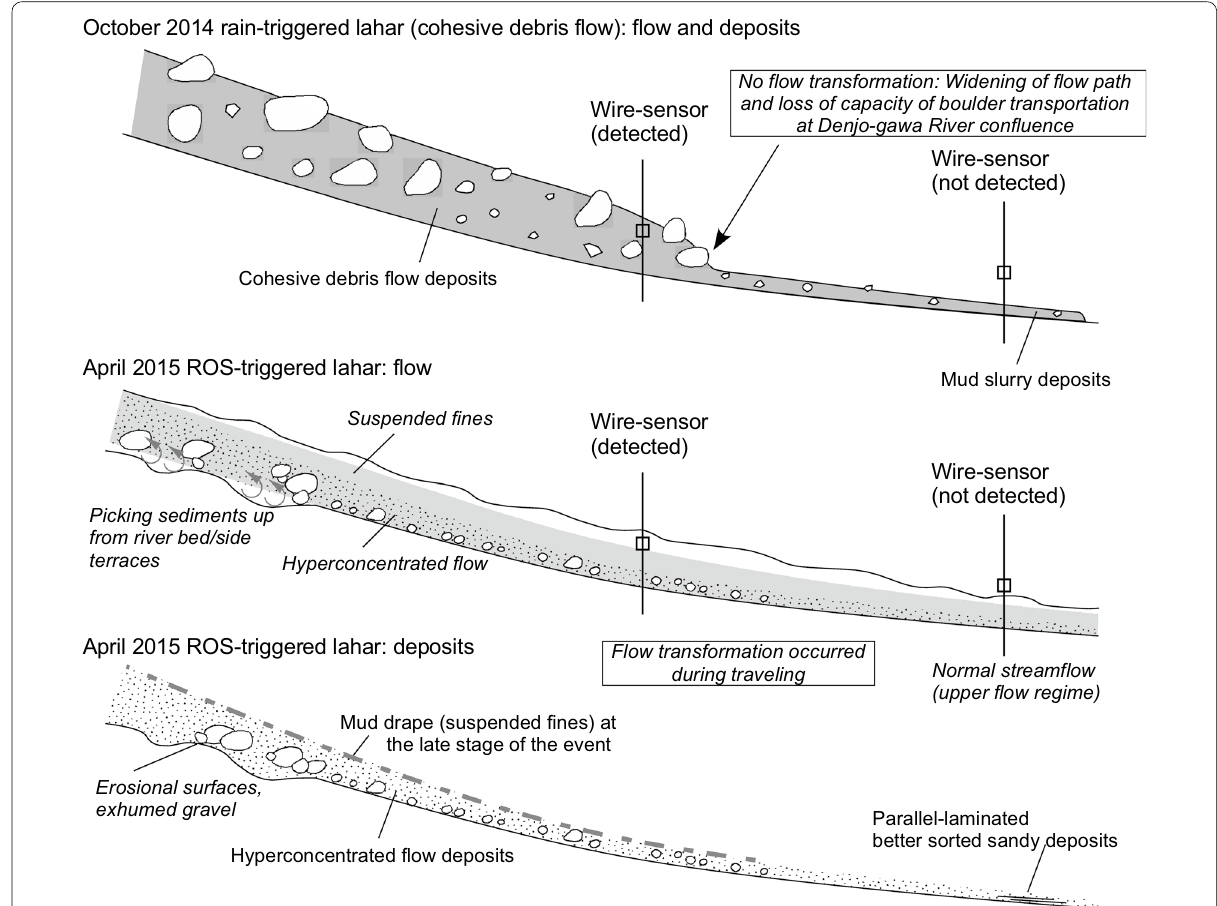
Fig. 10 Schematic illustration showing flow and depositional characteristics of two post-eruptive lahars in the Akagawa and Nigorigawa